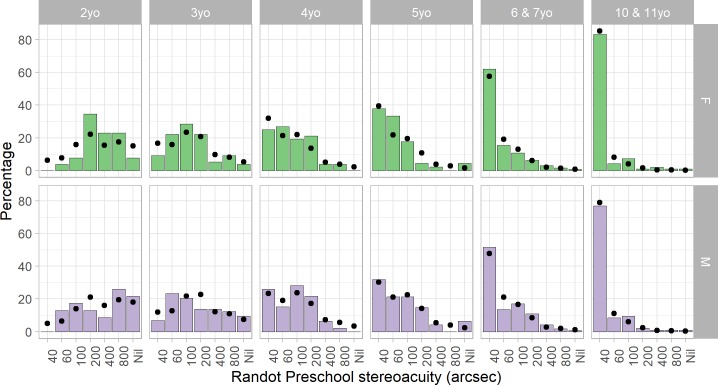
Distribution of normative Randot Preschool stereo thresholds in different age-groups, for children with normal vision, separated by sex.In children aged 4 and up, the most common outcome is 40 arcsec, the best score available. Dots show the fit of a descriptive model fitted to this data (Eq 1). For each child in the study, given their age and sex, the model estimated the probability of each possible score. We then averaged these across all children of a given sex and age-group to obtain the points shown. With 8 parameters fitted to the data, the model gives a reasonable account of the data in these 84 bins.